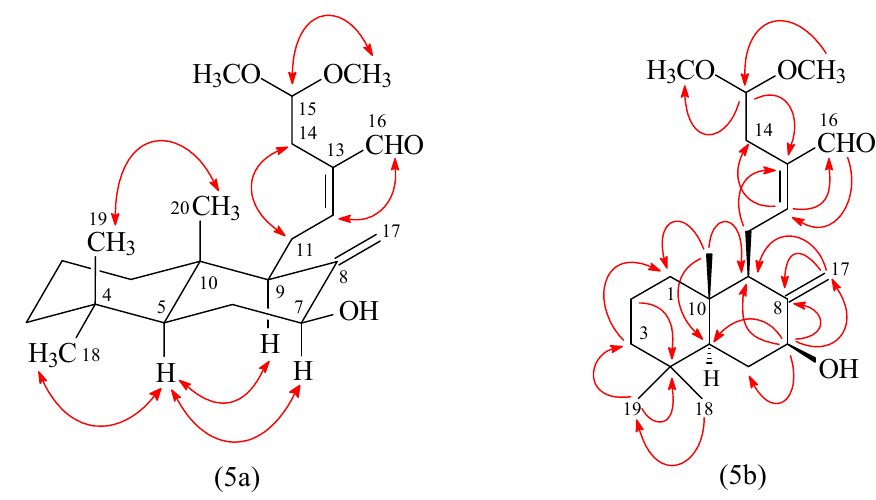
Figure 5. Key NOESY (5a) and HMBC (5b) correlations of 3